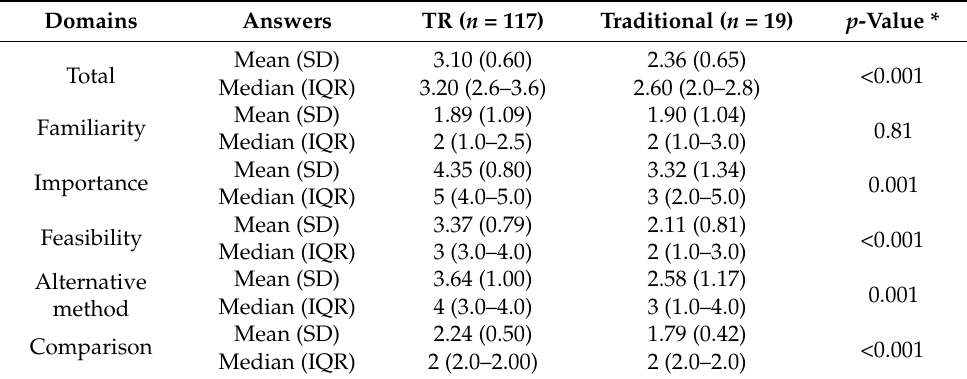
Table 3. Comparison between TR and conventional face-to-face